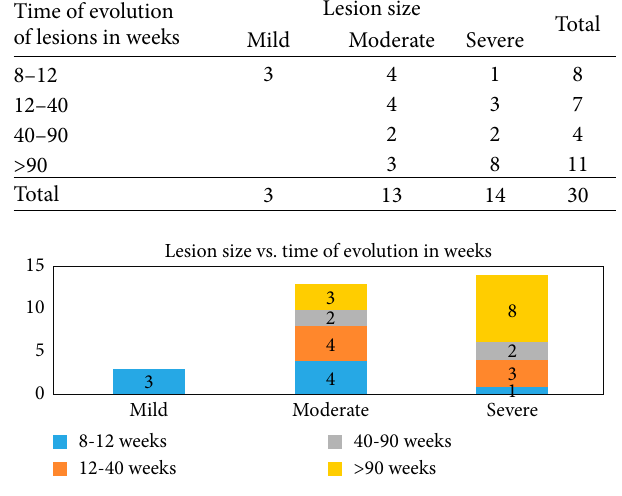
Figure 5: Time of evolution of lesions. Table 7: Treatment time with PolyHeal®